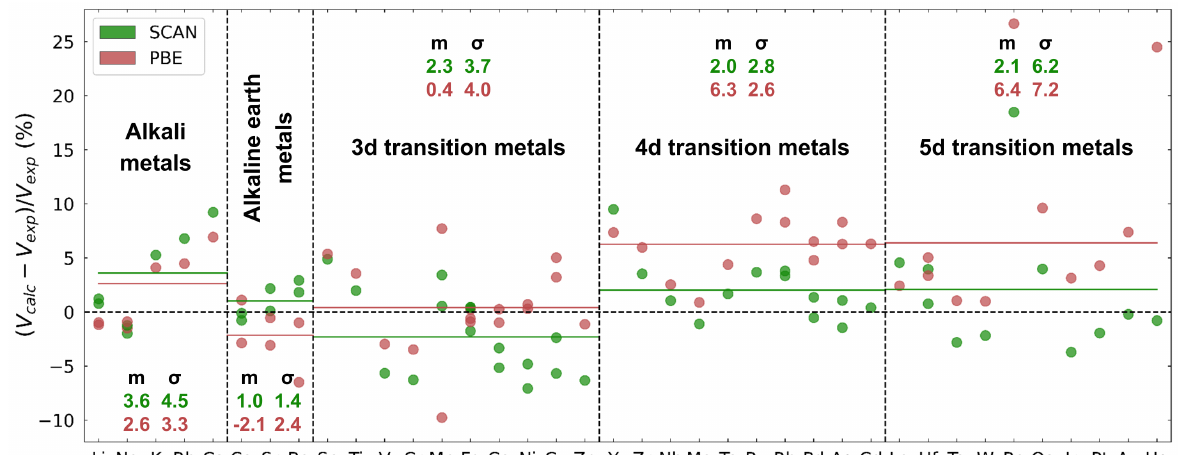
Figure 2. Comparison of the SCAN and GGA calculated equilibrium cell volumes ( V calc ) of alkali metals, alkaline-earth metals, and 3 d -, 4 d -, and 5 d -transition metals. All values are plotted with respect to the corresponding averaged experimental values of V exp . The zero dash line denotes the experimental data. The values of m and σ denote the mean and standard deviations from V exp for each group of metals. The data were collected from Refs.